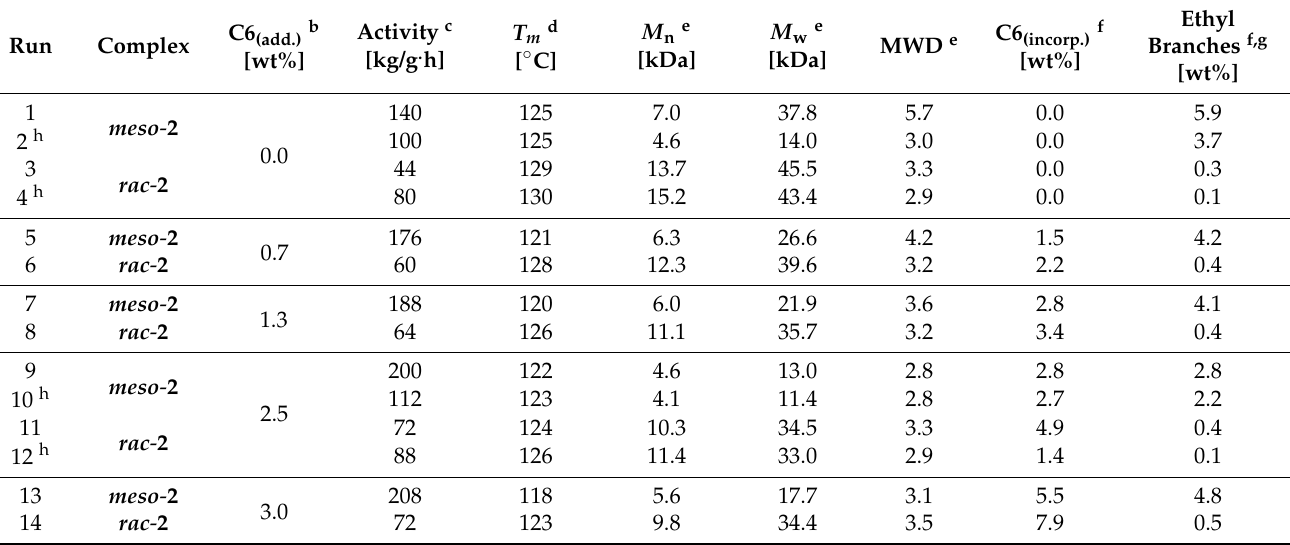
Table 1. Copolymerization of ethylene and 1-hexene catalyzed by homogeneous meso- and rac - 2 /MAO catalyst systems a